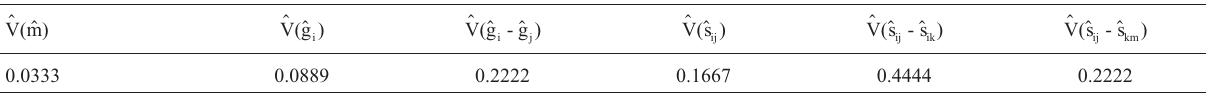
Table 8 - Estimates of the variances of the effects and contrasts from the complete diallel calculated using expressions cited in the literature.